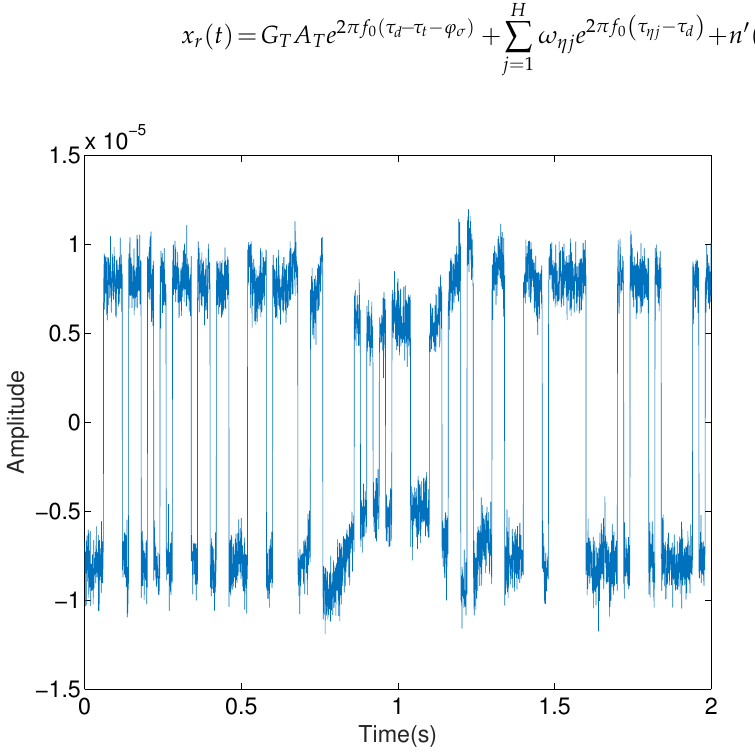
Figure 4. Output signal after code